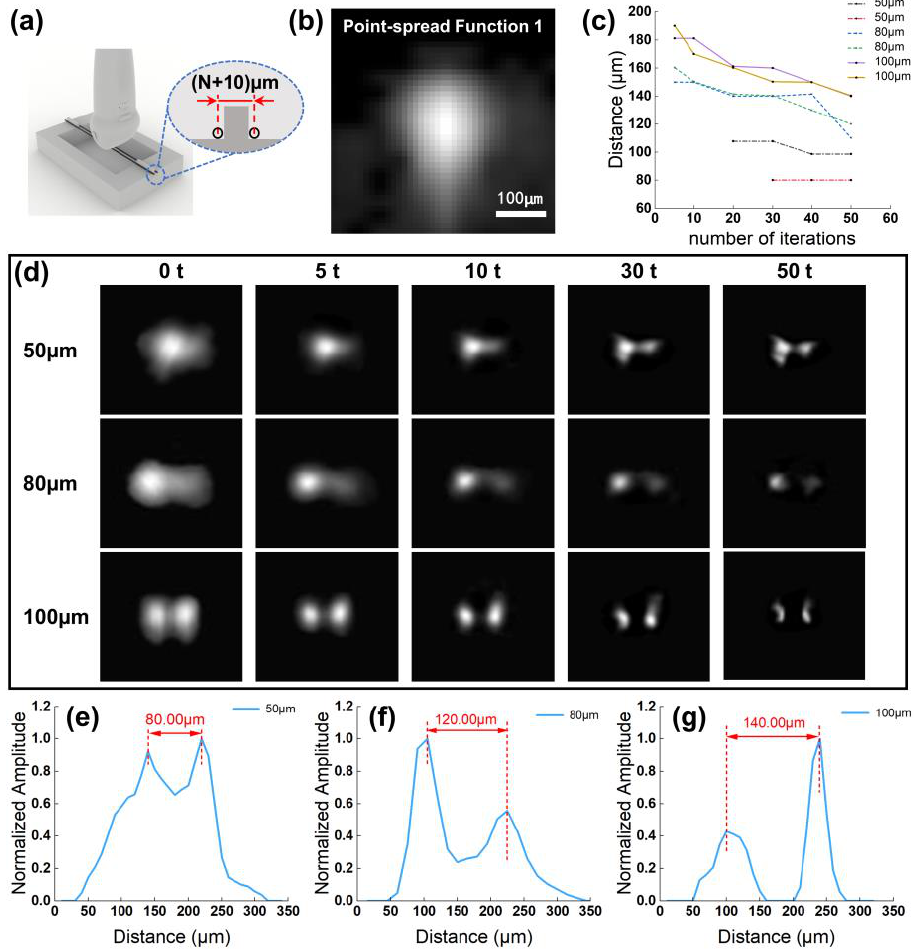
Figure 3. The quantitative analysis for image deconvolution algorithm in vitro tungsten model experiment. ( a ) Schematic diagram of the custom-made tungsten wire model. ( b ) Example US image of 10 µm tungsten wire target cross section at the focus of the imaging system. ( c ) The performance of Richardson–Lucy deconvolution algorithm in improving MBs localization precision. The axes indicate the calculated distance between two intensity peaks on the image after image deconvolution processing. Two sets of data were acquired for each pre-defined value. ( d ) US images of two-point scatterer phantom under different number of iterations in image deconvolution algorithm. From the 1st row to 3rd row, the distance between the center of the two points are 50 µm, 80 µm, 100 µm. Each column represents a different number of iterations. ( e – g ) The 1D lateral profiles crossing the centroid peak intensity corresponds to the last column of ( d ).